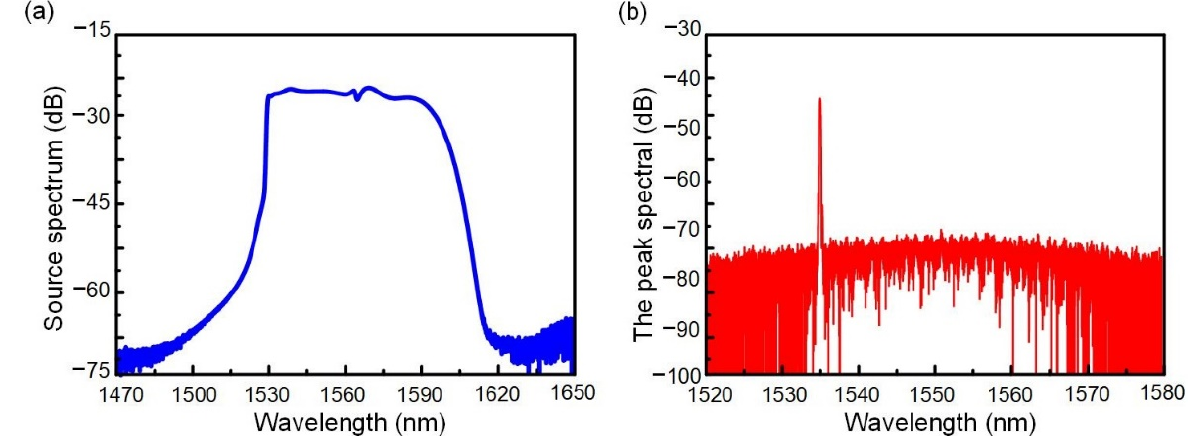
Figure 7. Experimental characterizations of two-sided WBG: ( a ) Output spectra of SLED broadband light source; ( b ) Temperature test results of two-sided WBG.